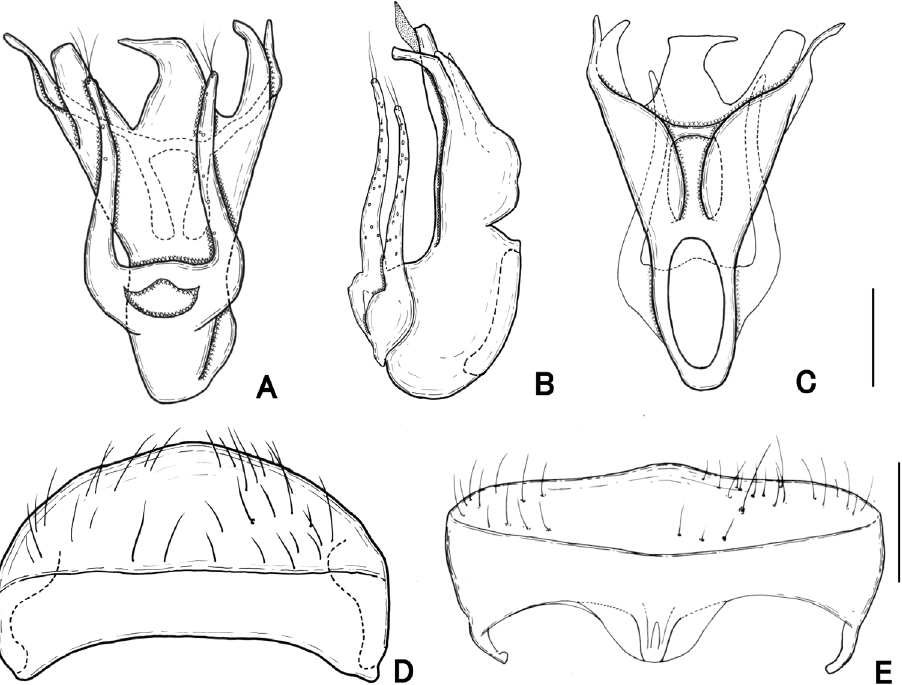
Figure 4. Male genitalia of Pseudophanias yaimensis A ventral view B lateral view C dorsal view D ter- gite VIII E sternite VIII. Scale bars: 0.1